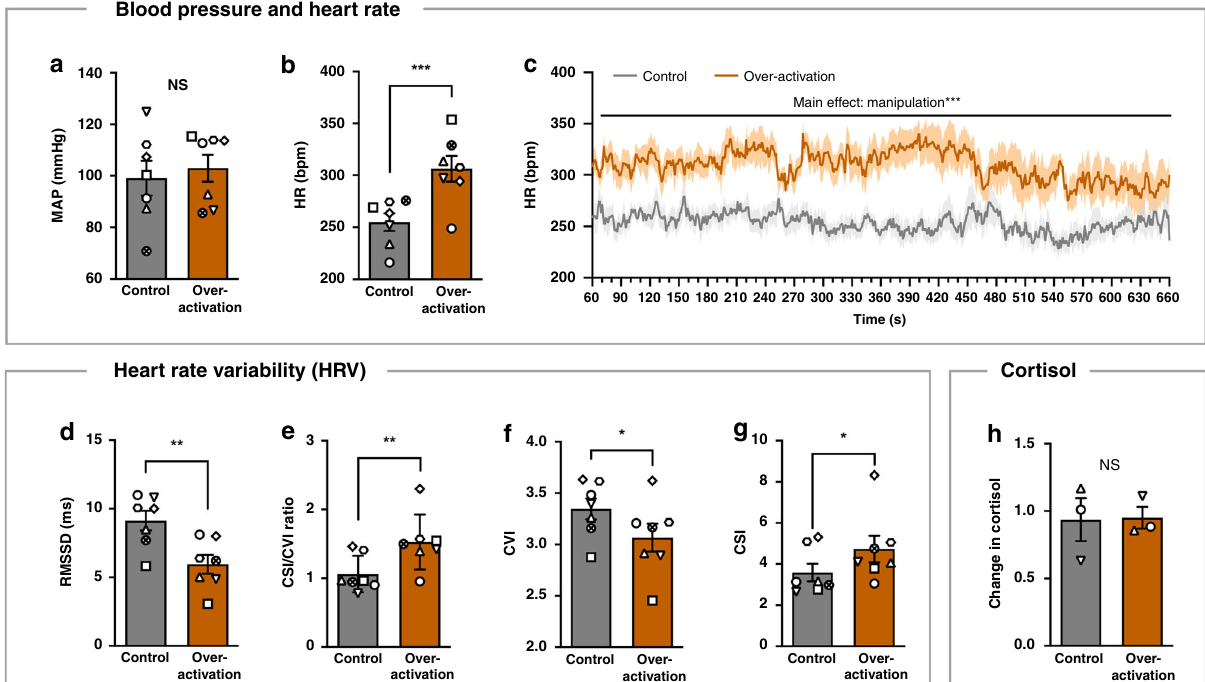
Fig. 2 sgACC/25 over-activation shifts the sympathetic-to-parasympathetic balance, increasing heart rate and reducing heart rate variability. Gray = control, orange = over-activation. Shading and error bars represent SEM. n = 7 except cortisol where n = 3. a sgACC/25 over-activation had no effect on blood pressure (mean arterial pressure, MAP) measured across the session (two-tailed paired t -test, p = 0.626). b sgACC/25 over-activation signi fi cantly increased heart rate (HR) measured across the session (two-tailed paired t -test, p < 0.001, d = 2.27). c Analysis of second-by-second heart rate values highlighted a systematic increase across the entire session (linear mixed-model, manipulation × time, F < 1, p = 0.999; main effect of manipulation, F = 3448, p < 0.001, d = 2.02). d sgACC/25 over-activation reduced heart rate variability (HRV) as measured by the root mean square differences of 1,5899 successive R-R intervals (RMSSD; two-tailed paired t -test, p = 0.001, d = 2.20). e Fractionating HRV into cardiac sympathetic (CSI) and cardiac vagal (CVI) indices revealed sgACC/25 over-activation shifted sympathetic/parasympathetic balance towards sympathetic predominance (two-tailed paired t- test, p = 0.004, d = 1.69). f sgACC/25 over-activation signi fi cantly decreased CVI (two-tailed paired t- test, p = 0.011, d = 1.38) and g signi fi cantly increased CSI (two-tailed paired t- test, p = 0.032, d = 1.07). h Cortisol levels did not change from before to after the habituation session (mean± SEM ratio: control 0.937 ± 0.159, over-activation 0.951 ± 0.080) and did not differ between control and over-activation conditions (two-tailed paired t -test, p = 0.960). Source data are provided as a Source Data fi